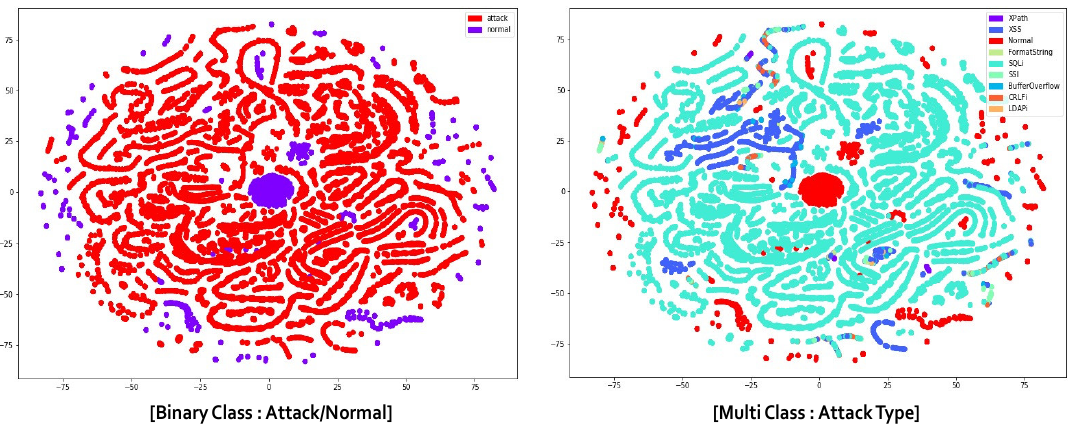
Figure 6. Results of t-SNE visualization for the CSIC2012 dataset.